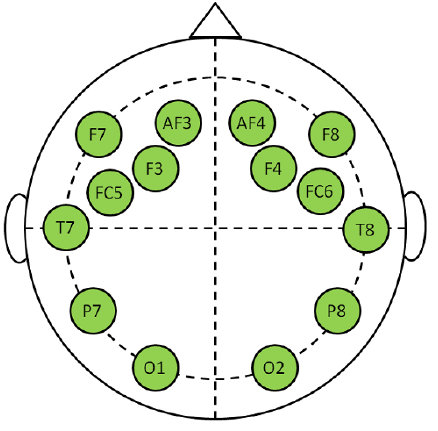
Figure 1. Emotiv EPOC headset—10–20 system.